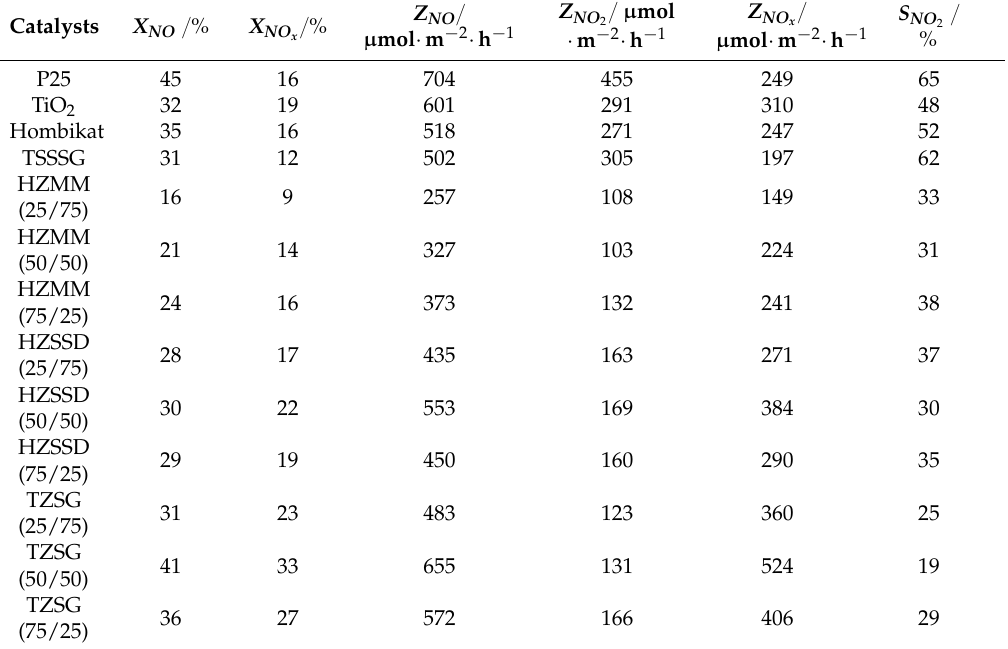
Table 1. Conversion of NO (X NO ) and of NO x (X NO photocatalytic oxidation of NO over different TiO 2 and TiO 2 /ZSM-5 composite catalysts after 24 h UV irradiation (5 g TiO 2 or composite, 1000 ppb NO, 50% relative humidity, 3 dm 3 ¨ min ´ 1 total